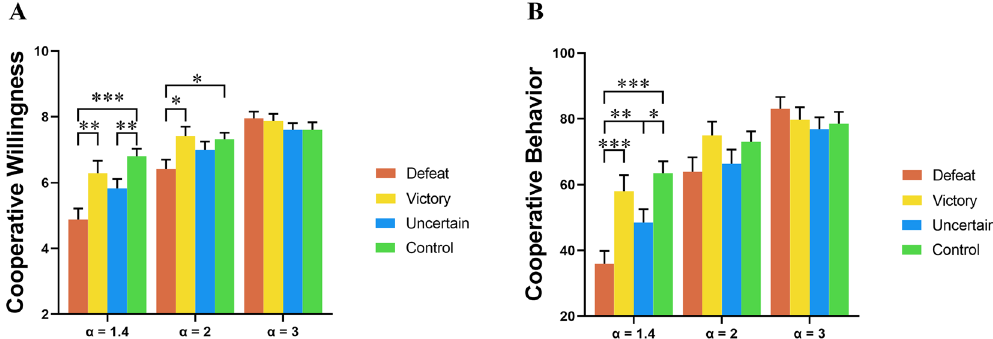
Figure 3. Effects of outcome feedback and the MPCR on participants’ willingness to cooperate and their cooperative behavior. With regard to participants’ willingness to cooperate with their opponents ( A ) and their cooperative behavior ( B ), an interaction between outcome feedback and the MPCR (α) occurred. * p < 0.05, ** p < 0.01, *** p < 0.001. Error bars represent ± 1